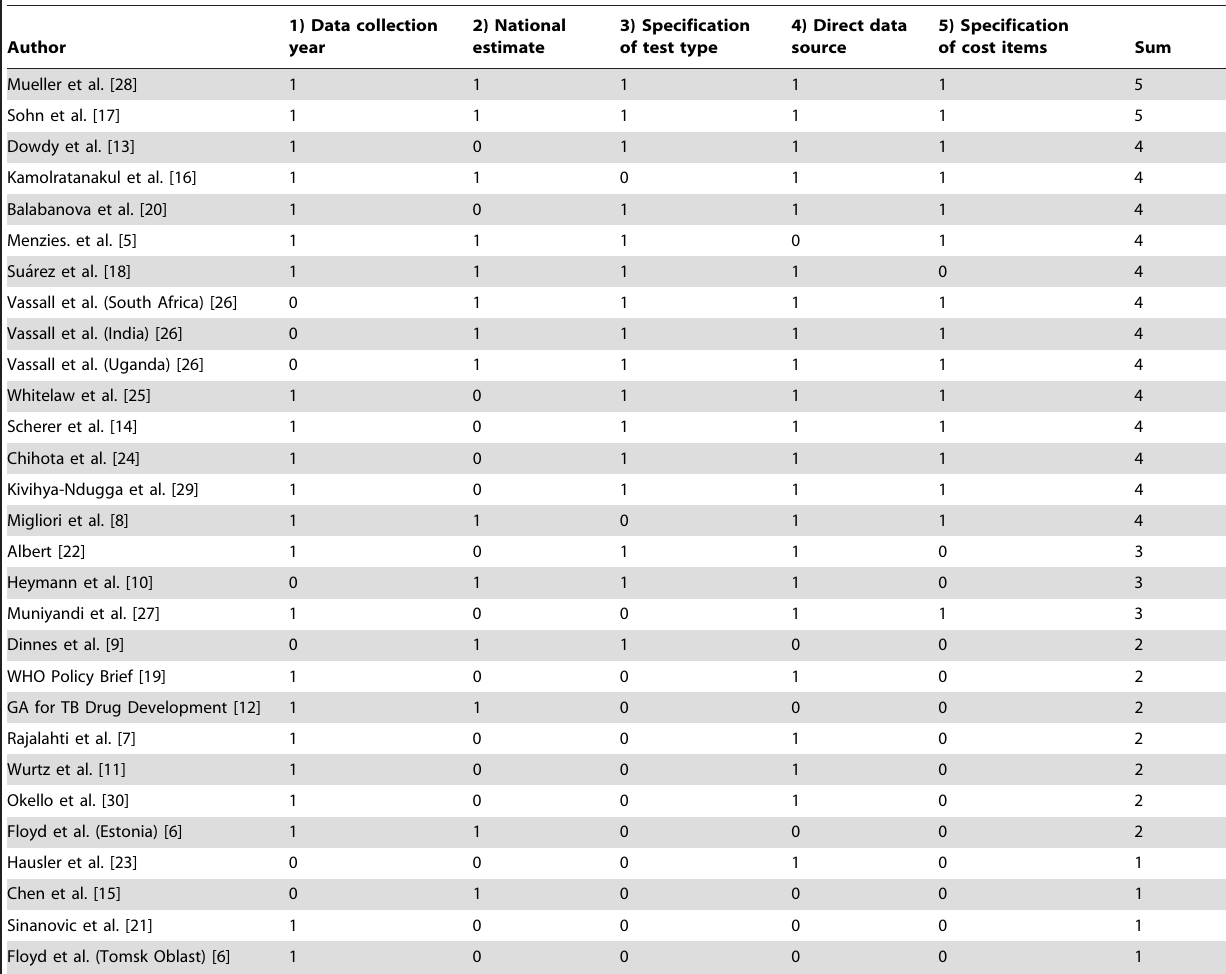
Table 2. Quality assessment of the studies (1 =yes; 0=